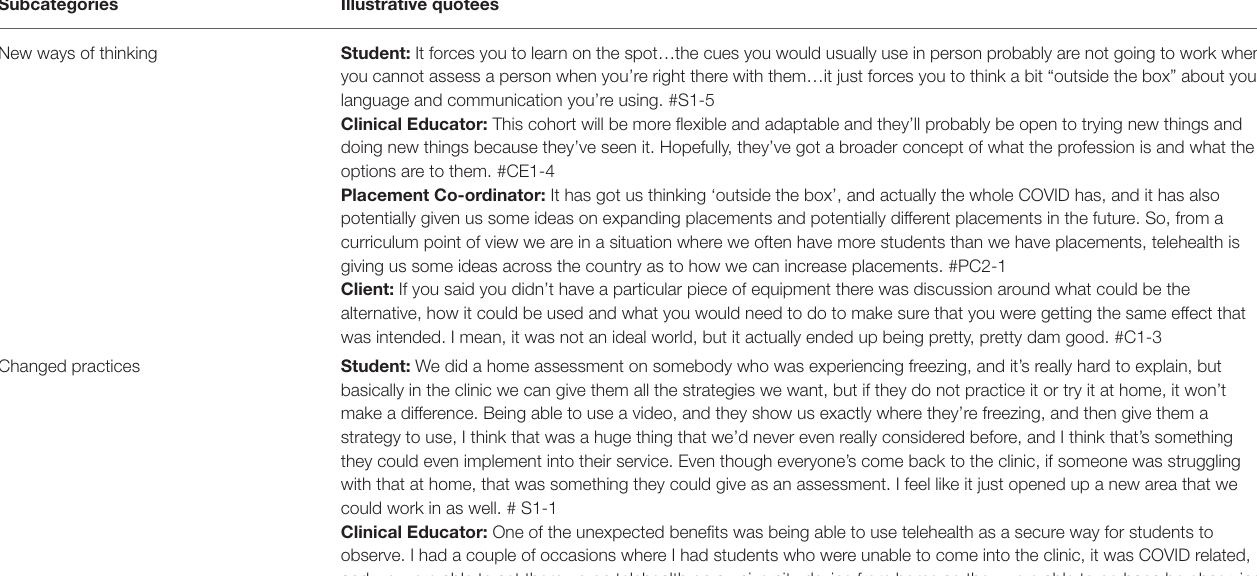
TABLE 4 | Theme 3: Telehealth placements enabled new innovation.